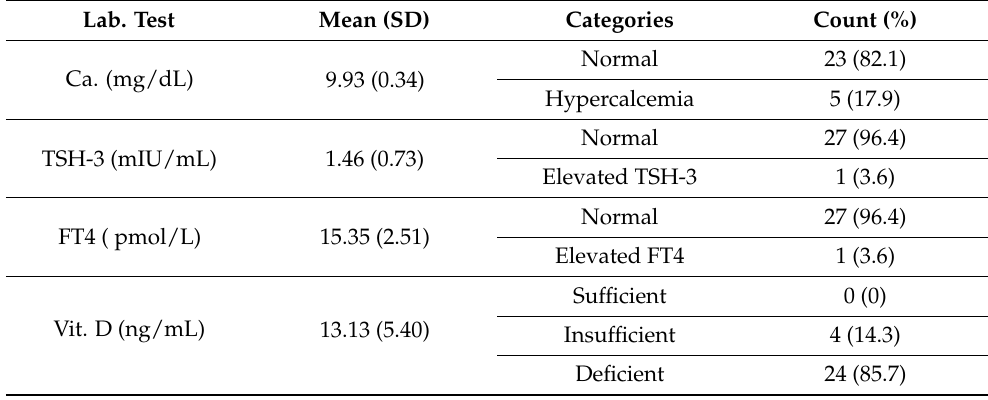
Table 2. Laboratory levels and categories of Ca, TSH, FT4, and Vit. D ( n = 28).